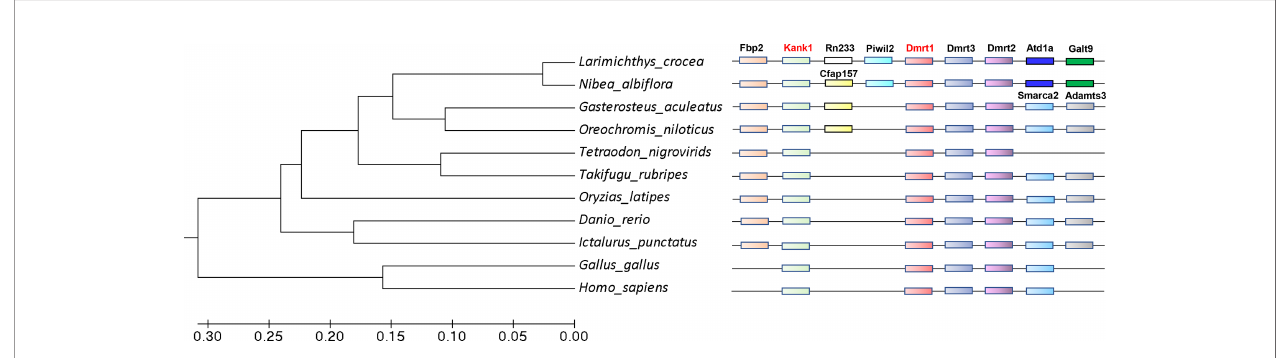
FIGURE 6 | The phylogenetic trees of dmrt1 and collinearity analysis between dmrt1 and kank1 . The different genes are represented by different color